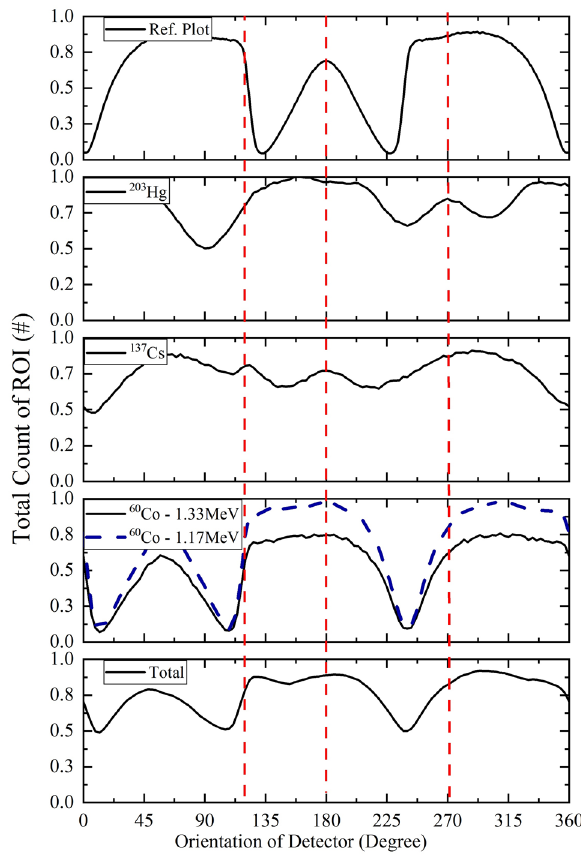
Figure 7. Total count of ROI (per particle) and total count versus orientation of detector in simultaneously presence of 203 Hg (5 μCi), 137 Cs (14 μCi) and 60 Co (25 μCi) in positions of −→ r 1